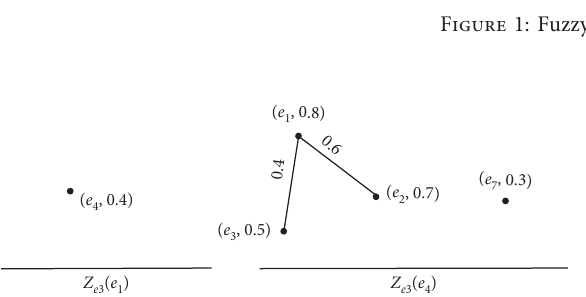
Figure 2: Fuzzy type-2 soft graph G � ( Z ( e